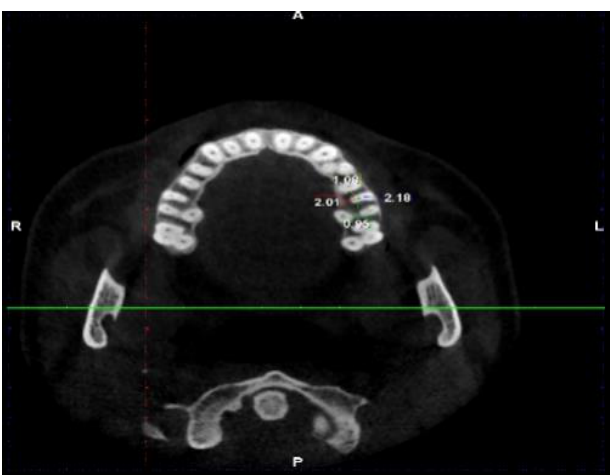
Fig. 3- A sample measurement on the CBCT image in apical